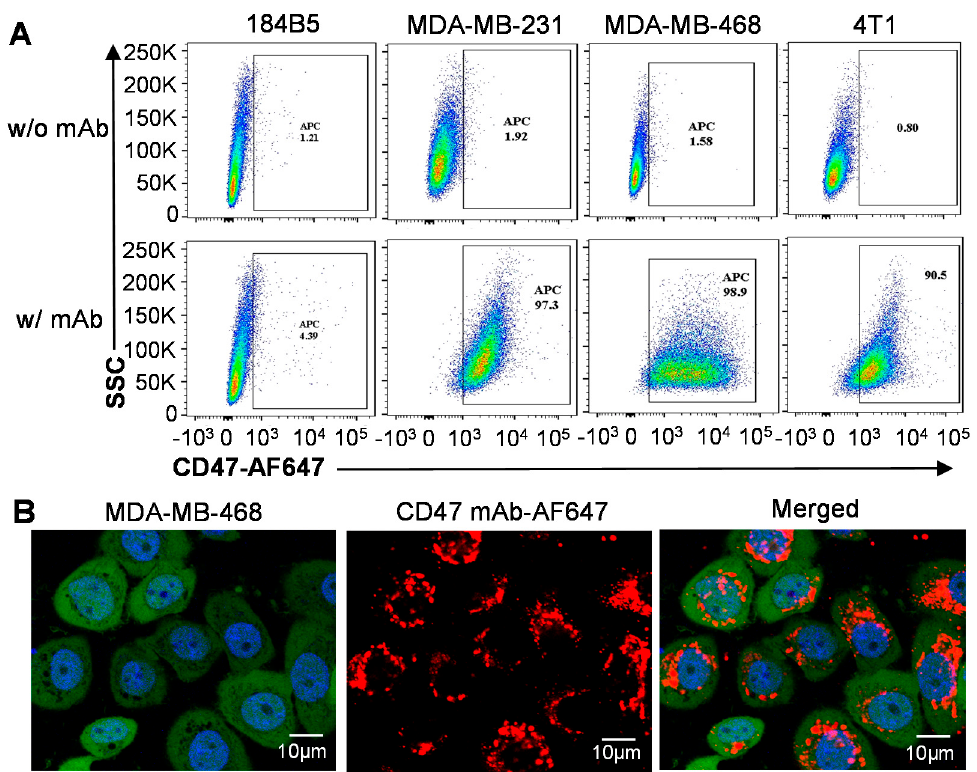
Figure 3. In vitro evaluation of surface binding and internalization of anti-CD47 mAb. ( A ) Flow cytometry to analyze the surface binding of anti-CD47 mAb to TNBC cells (MDA-MB-231, MDA-MB-468, and 4T1) and negative control cells (184B5). ( B ) Live-cell confocal microscopy imaging of the internalization of anti-CD47 mAb in MDA-MB-468 cells. Cytoplasm labeled with GFP (displayed as green), nucleus labelled with NucBlue (blue), and mAb-labeled with AF647 (red). Scale bar equals 10 µm.